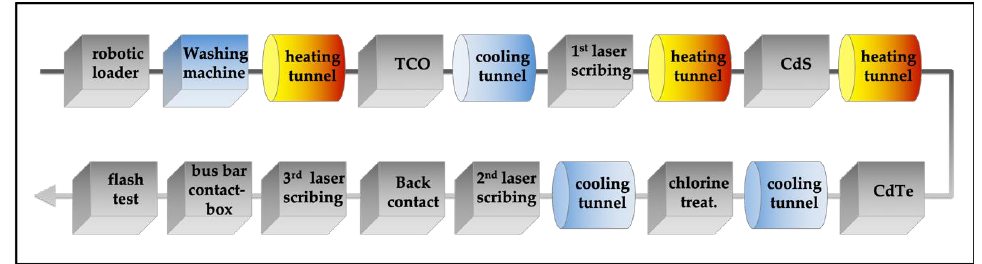
Figure 11. Flow diagram of a fully automated in-line process for the production of CdTe/CdS based PV modules.